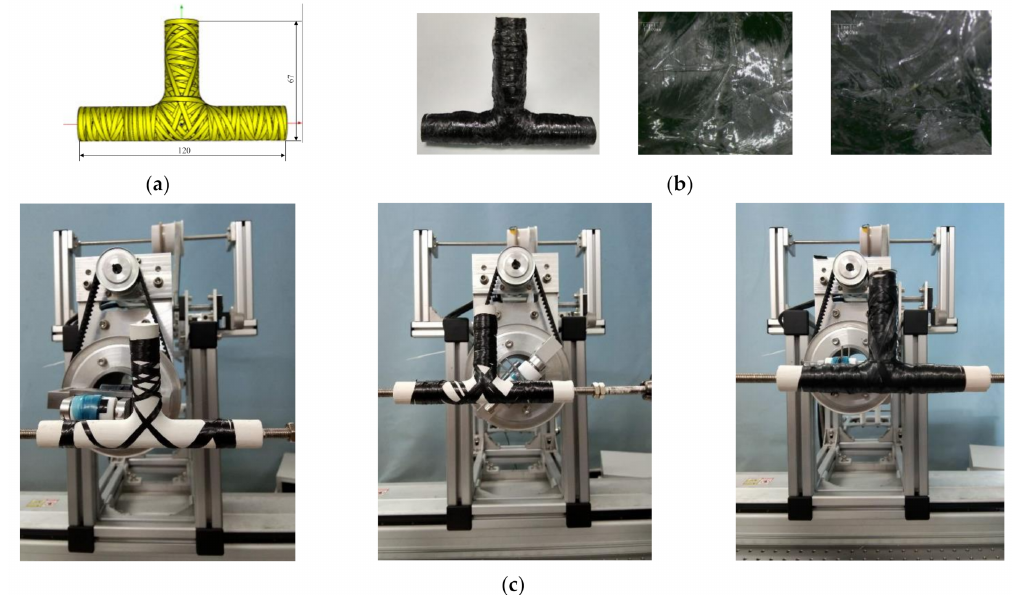
Figure 13. Winding experiment with a desktop winding machine ( a ) Designed trajectory by FiberStudio; ( b ) Cured tee pipe and its microscope view of T-junction; ( c ) Three different phases of the winding